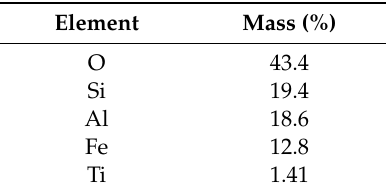
Table 4. Averaged mass percentage concentrations of the major elements in dried Dunino halloysite (energy-dispersive X-ray spectroscopy (EDS) analysis). Element